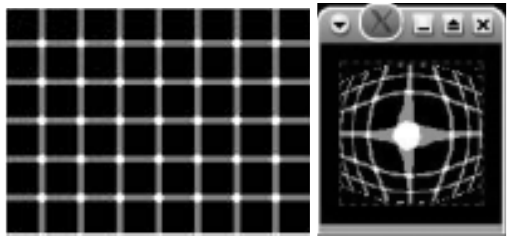
Figure 6 Test image and the corresponding gauss filter output.